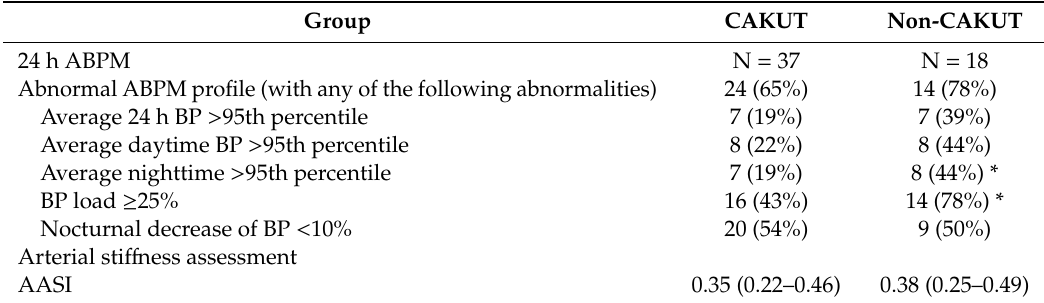
Table 2. ABPM profile and arterial sti ff ness assessment in children with CKD. Group CAKUT Non-CAKUT N = 37 N = 18